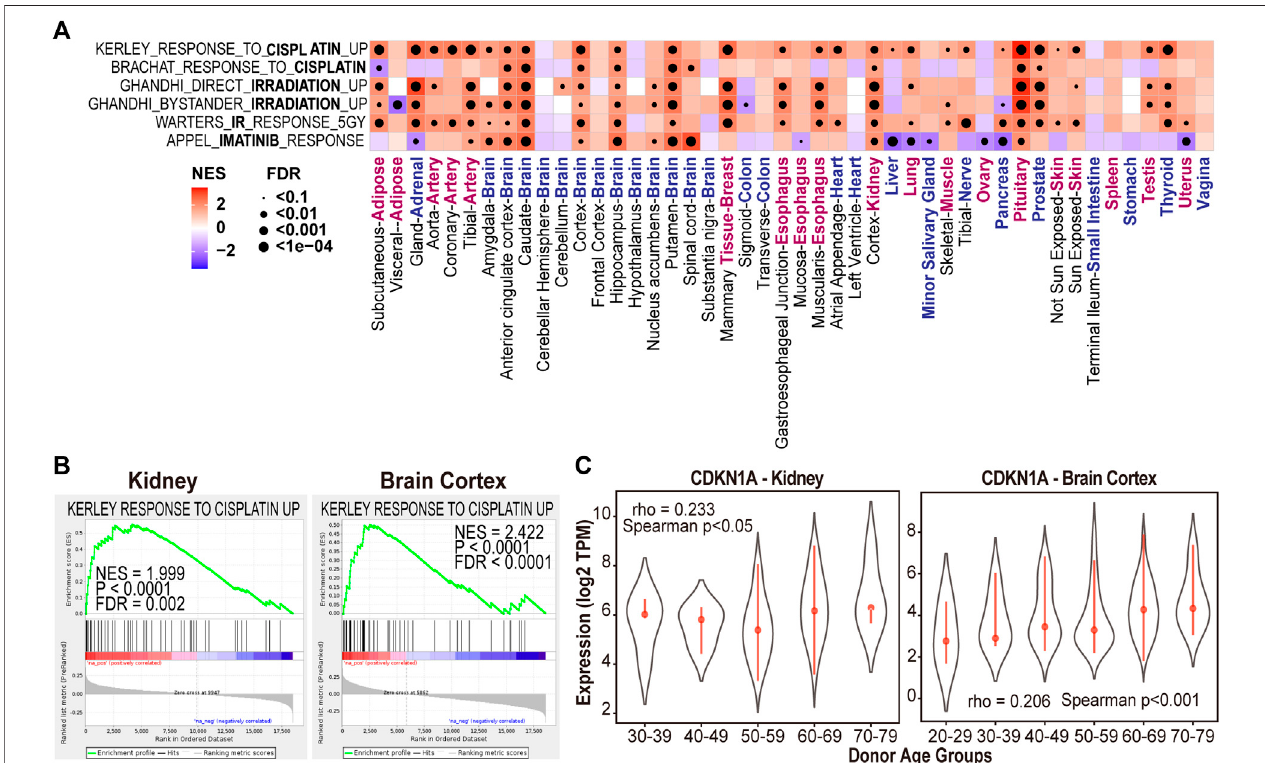
FIGURE 4 | Aging-associated genes are enriched with cancer drugs induced gene sets in multiple tissue types. (A) NES and FDR of GSEA analysis of treatment- induced gene sets in each tissue type. (B) Cisplatin induced gene set enriched with genes highly expressed in kidney and brain cortex samples of aged donors. (C) CDKN1A expression in kidney and brain cortex tissues of different donor age groups.